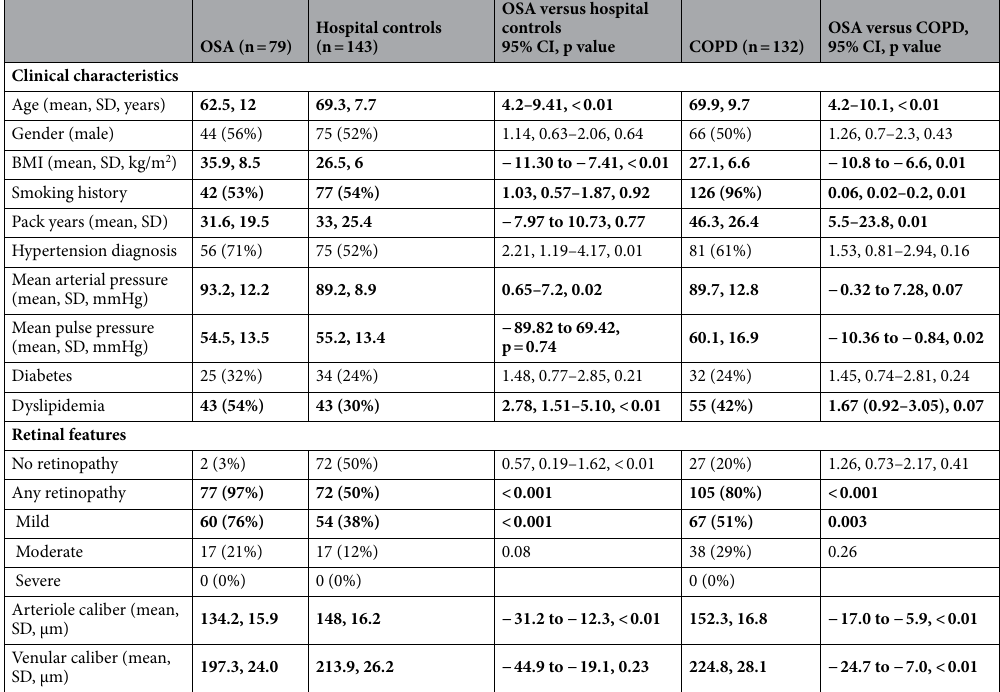
Table 1. Baseline demographic and clinical characteristics of subjects with OSA, hospital controls and subjects with COPD. Significant values are in